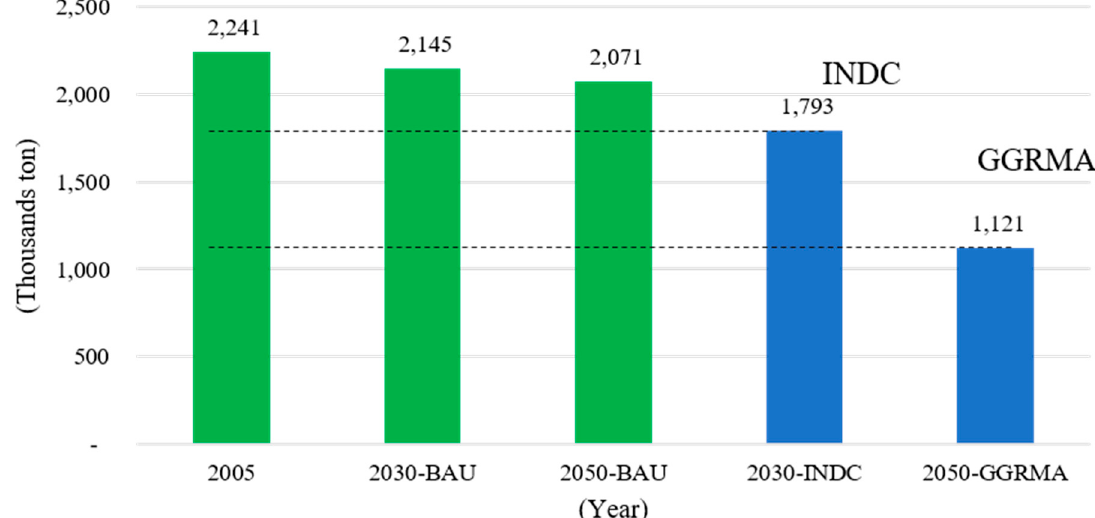
Figure 3. The disparity in port emissions in different scenarios.